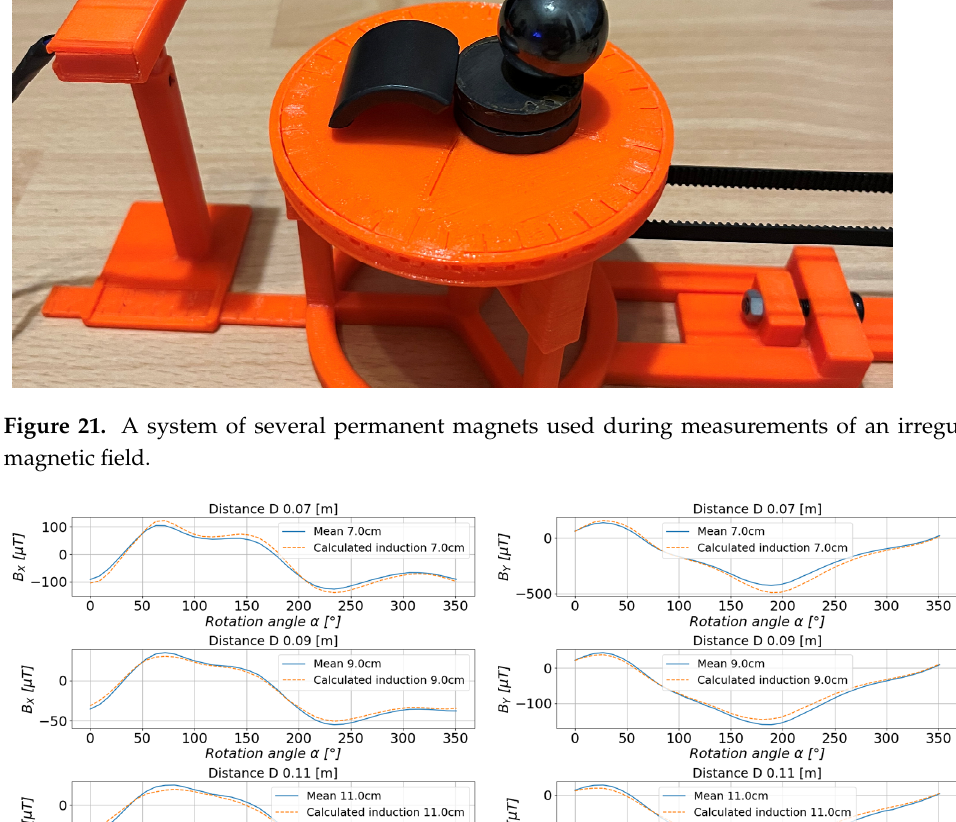
Figure 24. The comparison of the relative errors of the estimated values at the control points of the permanent magnet system. The obtained measurement results are presented in the form of 3D graphs in Figures 25 and 26 and in tabular form in Tables 7–10.